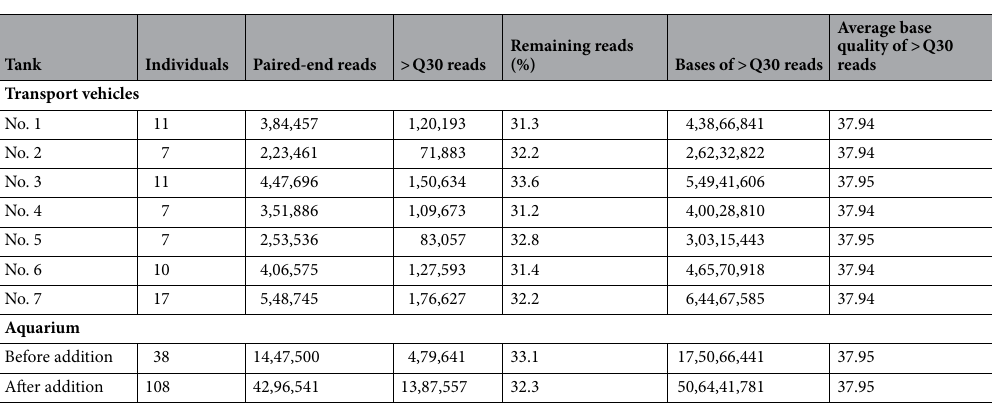
The HaCeD-Seq analysis of water samples from the aquarium tank detected 90 out of the 96 haplotypes (94%) when the UMI tags were used (Fig. 5). However, HaCeD-Seq analysis without the UMI tags detected only 29 haplotypes (30%), with two false haplotypes. These results show that when a large number of haplotypes need to be detected (i.e., greater than 100), the UMI tags are essential to obtain the correct number of haplotypes.